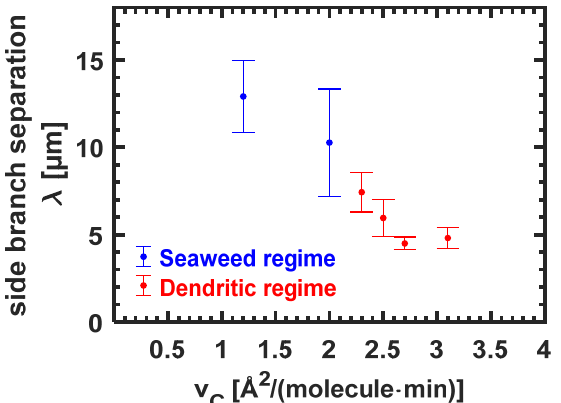
Figure 7. Side branch separation λ versus the compression velocity v C for six different monolayers of erucic acid (cf. Figure 1). For each monolayer, about 20 different domains were analyzed. The domains nucleated at different lateral excess pressure Δ𝜋 .